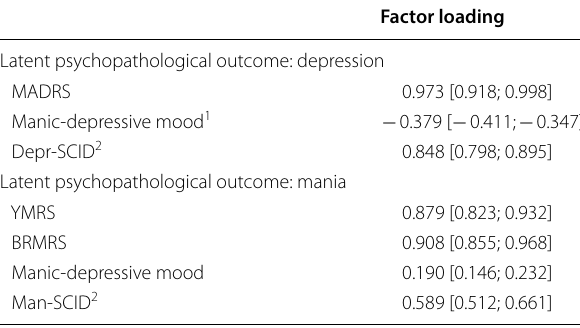
psychopathological outcome for depression (upper